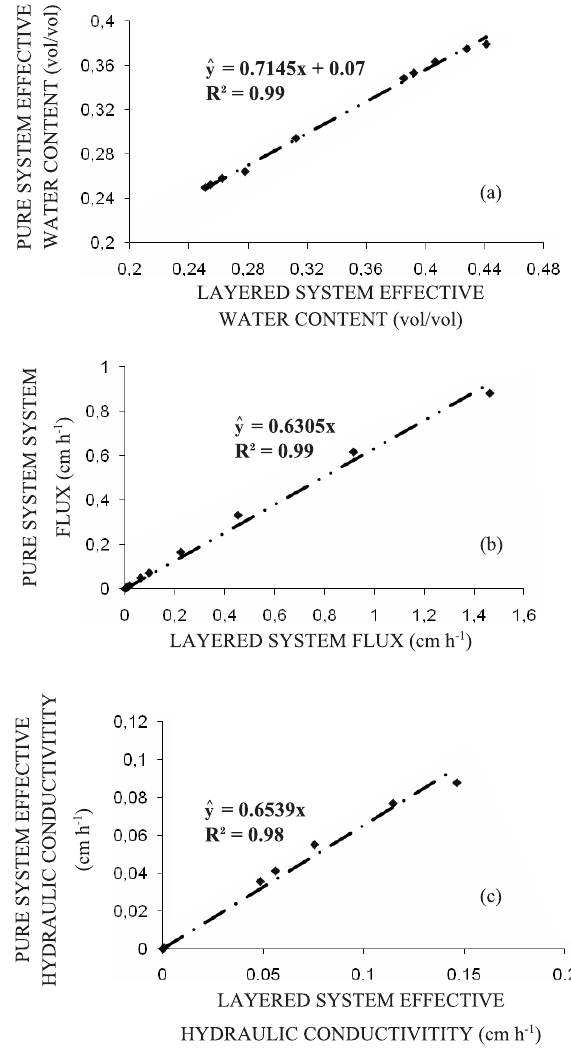
6. Comparison of results of water contents (a), hydraulic fluxes (b) and hydraulic conductivities (c) between pure phase and layered